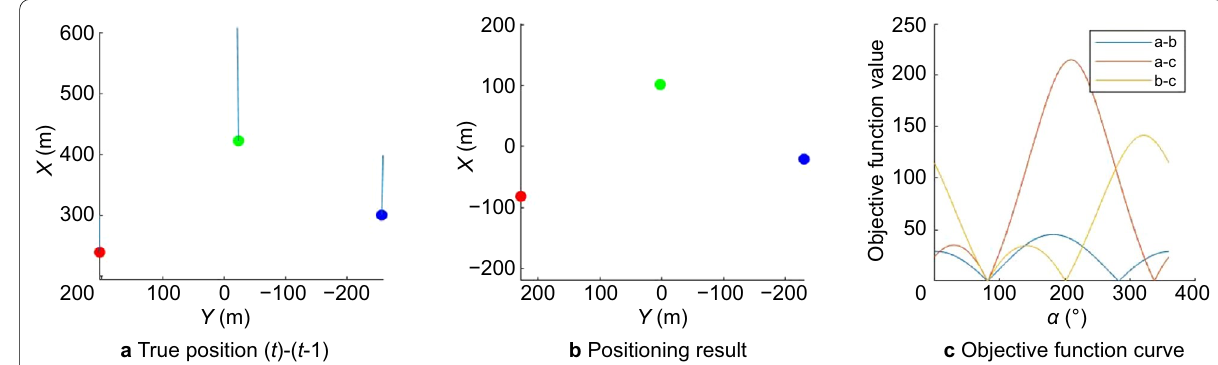
Fig. 9 Parallel formation (non-constant velocity) scenario, simulation results at time t = 1